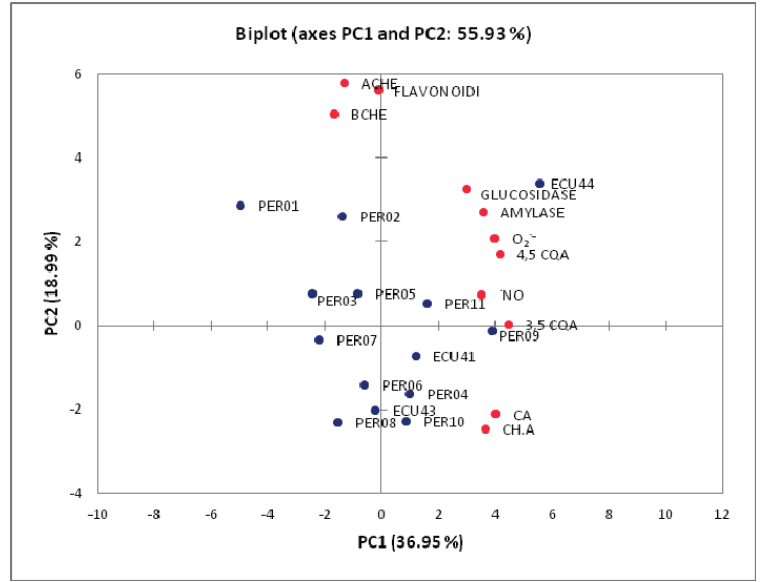
Figure 4. Principal component analysis (PCA) among biological activity and chemical profile of investigated yacon